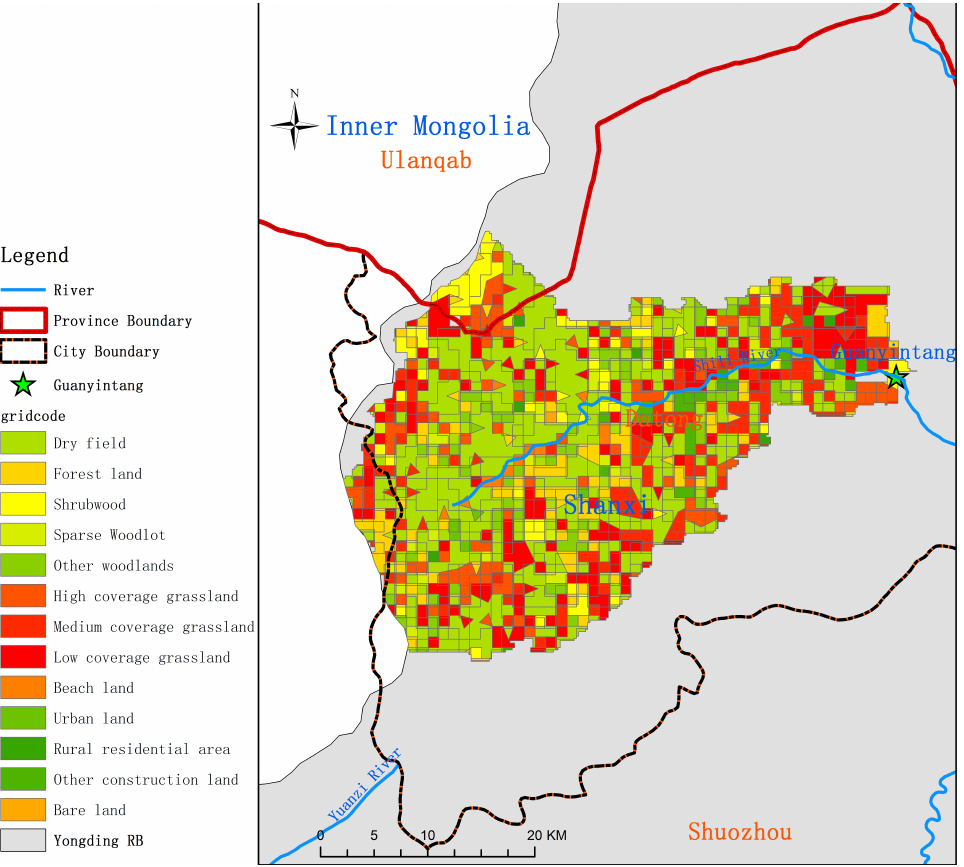
Figure 3. Land cover map of the Guanyintang River